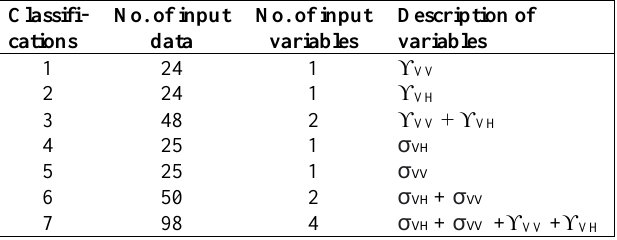
Table 1. Input data of experiments for croplands classification